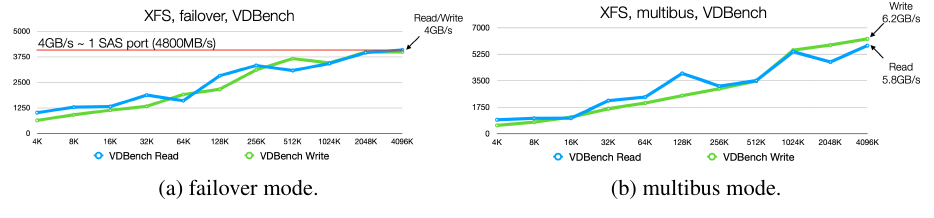
Figure 3: The read / write test results in two di ff erent multipath modes: failover and multibus